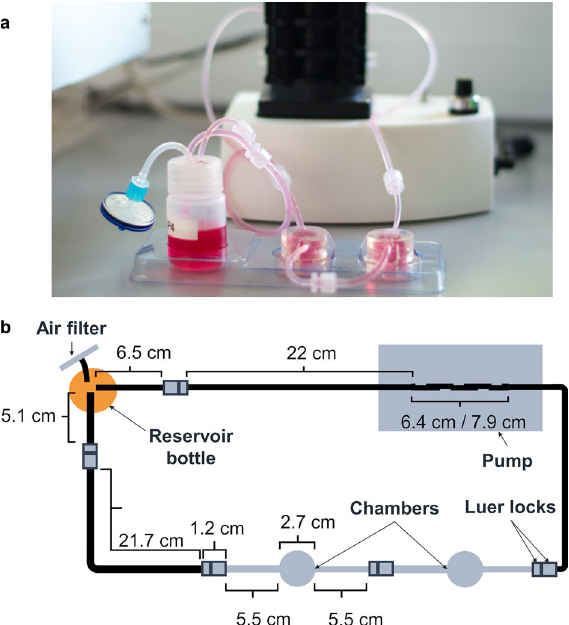
Figure 6. The QuasiVivo system. ( a ) The assembled QuasiVivo system. Medium moves from the reservoir bottle (on left) towards the pump, where the peristaltic movement is created. Then, it flows through the chambers, where cells are cultured, and returns to the reservoir bottle. The tubes are connected with luer locks. ( b ) Measures of QuasiVivo system. The pump tubing length depends on the used pump, PF22X0103 having longer